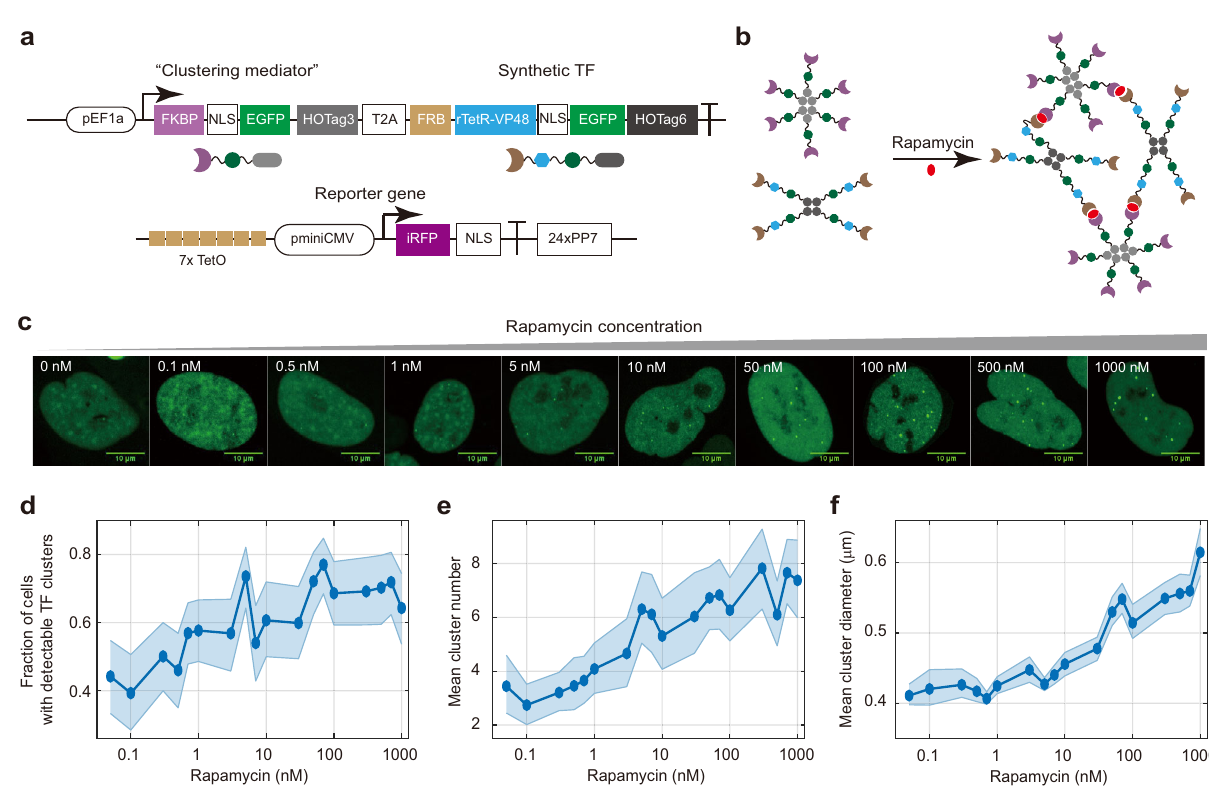
Fig. 1 A synthetic gene regulatory system with chemically controlled TF clustering propensity. a , b Schematic of the system design. Our design is built upon a previously reported rapamycin-inducible clustering mechanism. The synthetic TF contains DNA binding domain (e.g., rTetR) and trans-activation domain (e.g., VP48), fused with FRB, EGFP, and a homo-oligomeric tag HOTag6 ( a ). This synthetic TF is co-translated with a “ clustering mediator ” composed of FKBP, EGFP, and HOTag3. The cognate reporter of the TF contains iRFP and 24x PP7 stem loops. The system also contains a plasmid encoding PCP-3xmCherry for visualizing nascent transcription (not shown). TF clustering is mediated by rapamycin-mediated binding between FRB and FKBP ( b ). c – f Rapamycin modulates TF clustering propensity. Representative confocal images (maximum projection of z slices) of monoclonal U2OS cells containing the preceding system were treated with rapamycin at indicated concentrations ( c ). See “ Methods ” for details on imaging. Scale bars indicate 10 μ m. The fraction of cells containing detectable TF clusters ( d ), the averaged detected cluster number per cell ( e ), and the averaged cluster diameter ( f ) are quanti fi ed. The rapamycin concentrations are 0.05, 0.1, 0.3, 0.5, 0.7, 1, 3, 5, 7, 10, 30, 50, 70, 100, 300, 500, 700 and 1000nM (left to right), and the cell numbers are between 70 and 117 (see source data for the exact cell number). The shaded regions indicate 95% CI by bootstrap. See also Supplementary Fig. 1b, c. Source data are